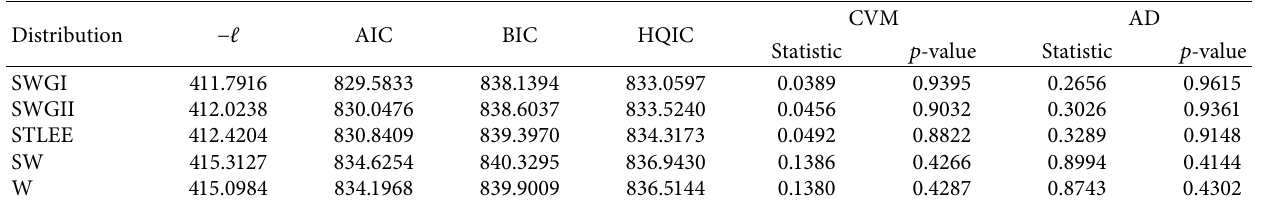
Table 6: Information criteria and goodness-of-fit measures of bladder cancer data.